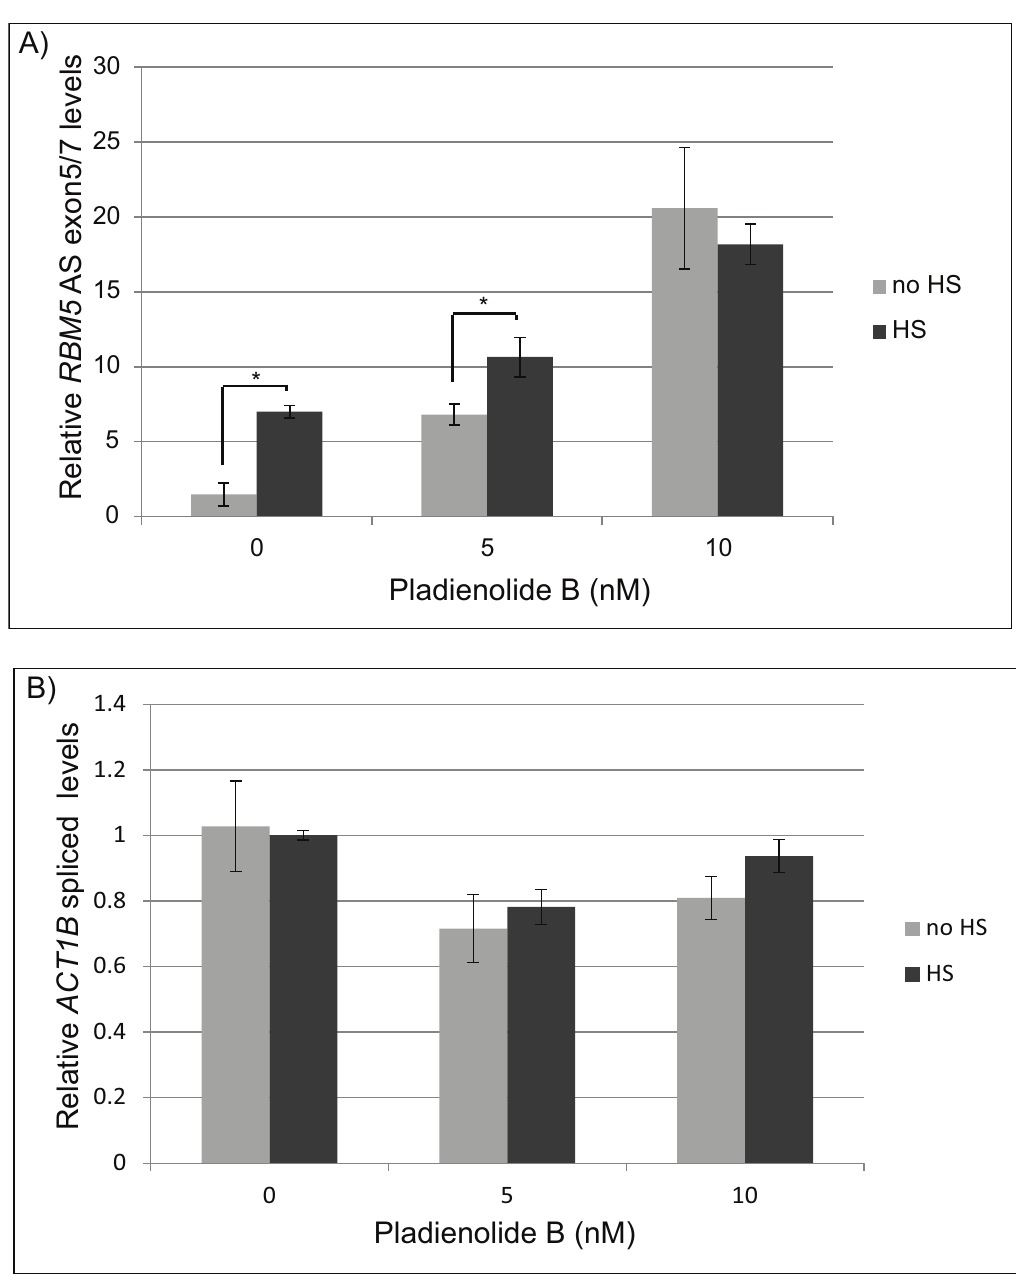
Fig 5. SF3B1 activity is sensitive to temperature. qRT-PCR analysisof (A) an alternatively splicedvariant of the RBM5 transcript that is known to be regulatedby SF3B1 and (B) the normalsplice variant of ACT1B in cells incubated with varyinglevels of PB for 16 hours +/- heat shock at 42˚ for 1 hour before harvest. Data is normalized to the no drug, no HS control. * indicatesp-value < 0.05.